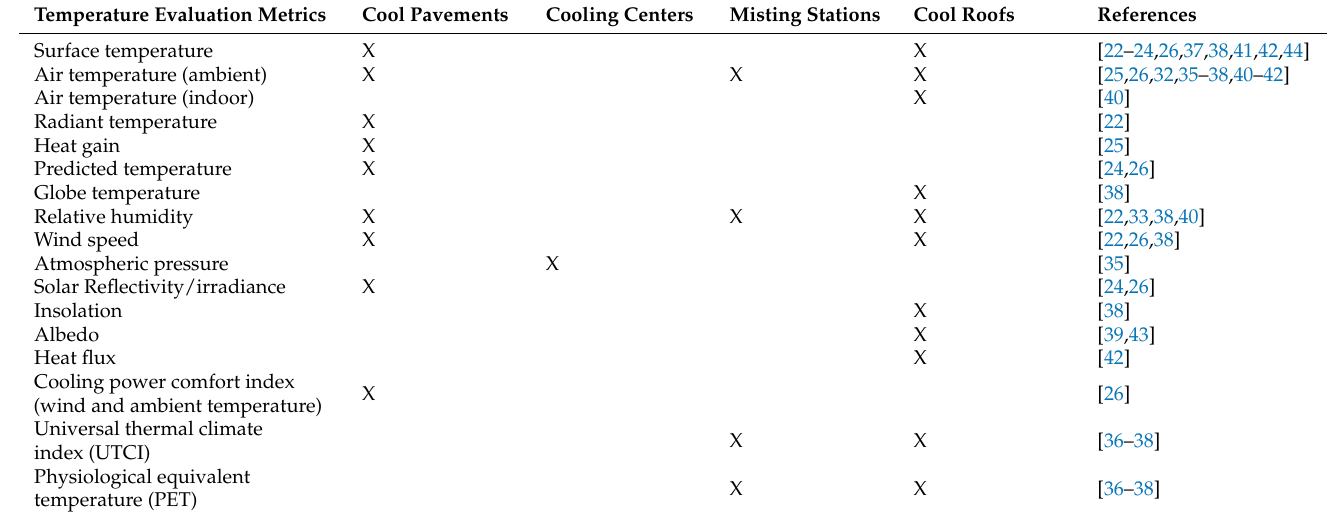
Table 3. Temperature metrics and derived indexes used to evaluate cool pavement, cooling center, misting station, and cool roof interventions.